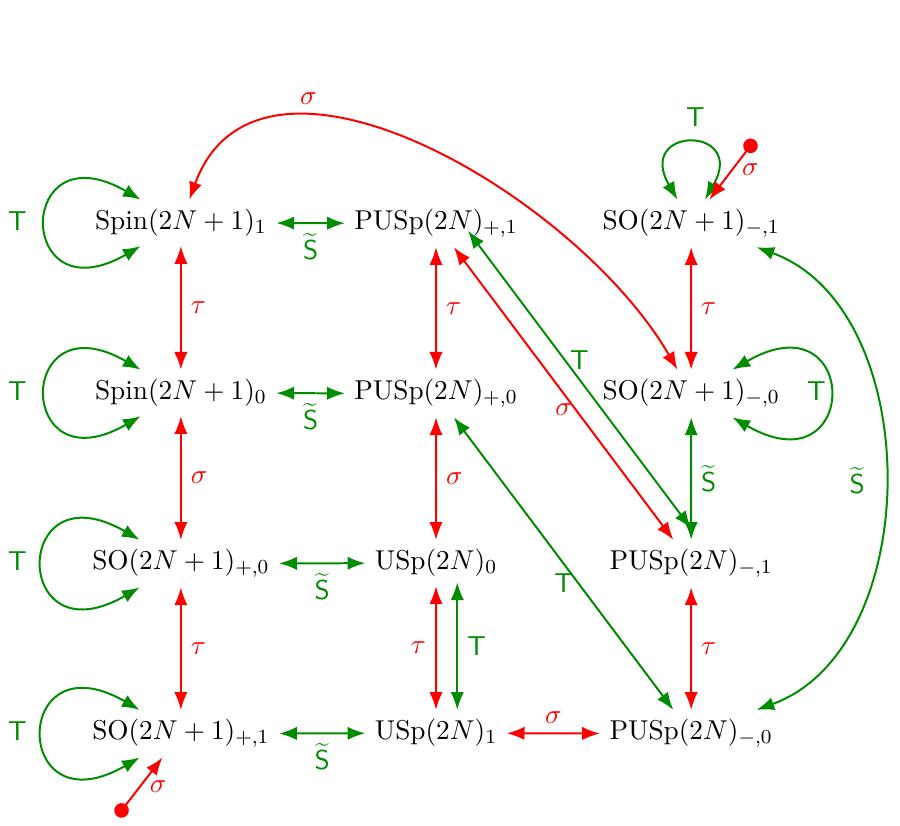
Figure 11 . Web of transformations for theories with gauge algebra usp (2 N ) for N odd.